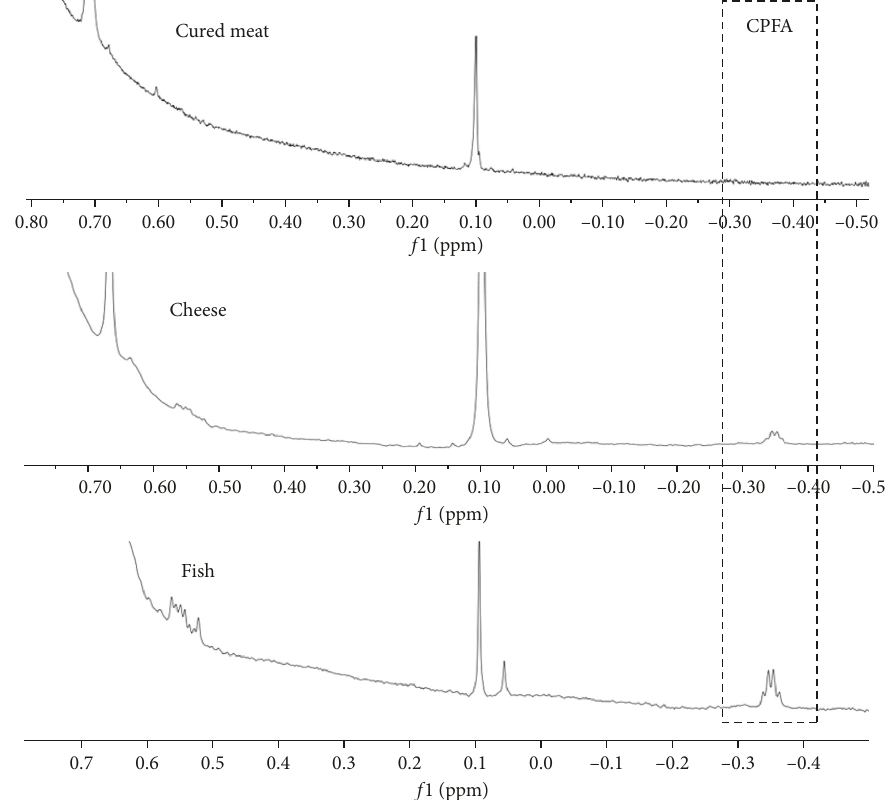
Figure 5: Enlargement of 1 H NMR 600MHz spectra in the zone from − 0.5 to 0.8ppm, showing the signal of the cyclopropane ring (at − 0.35ppm) used for CPFA quantification in cured ham (negative to CPFAs) and cheese and fish fat (positive to CPFAs). Table 1: Comparison of 1 H NMR and GC-MS results on the presence of CPFAs in some representative samples of fat of animal origin. Number of Samples